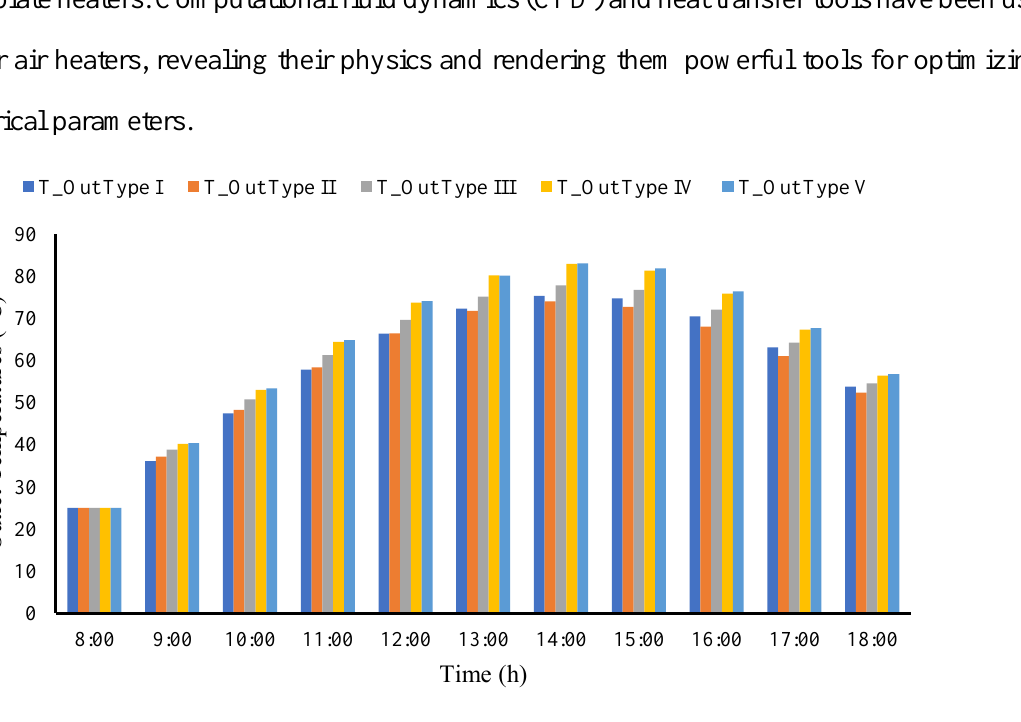
Figure 7. The temperature of the air outlet at different distances a flat absorber from the collector base. Temperature efficiency with various absorber locations from the bottom of the collector. There is a decrease in values during the middle of the day compared to the morning and evening. Due to the higher temperature of the system's primary components at midday, there are more thermal losses at that time.